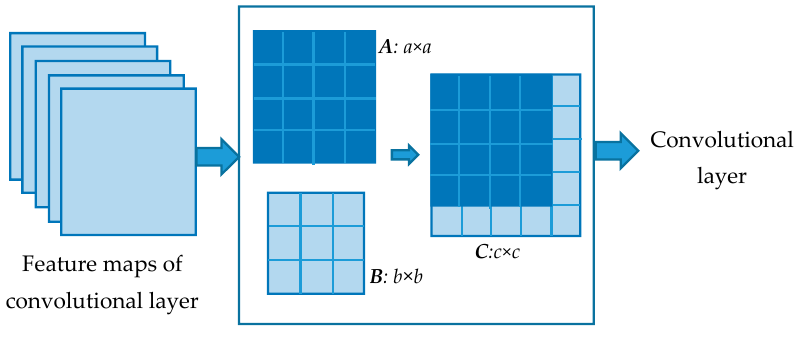
Figure 5. Structure of Pythagorean spatial pyramid pooling (PSPP) layer. It constructs the output using the results of two pooling levels. The position information of the higher-level pooling result A are retained.